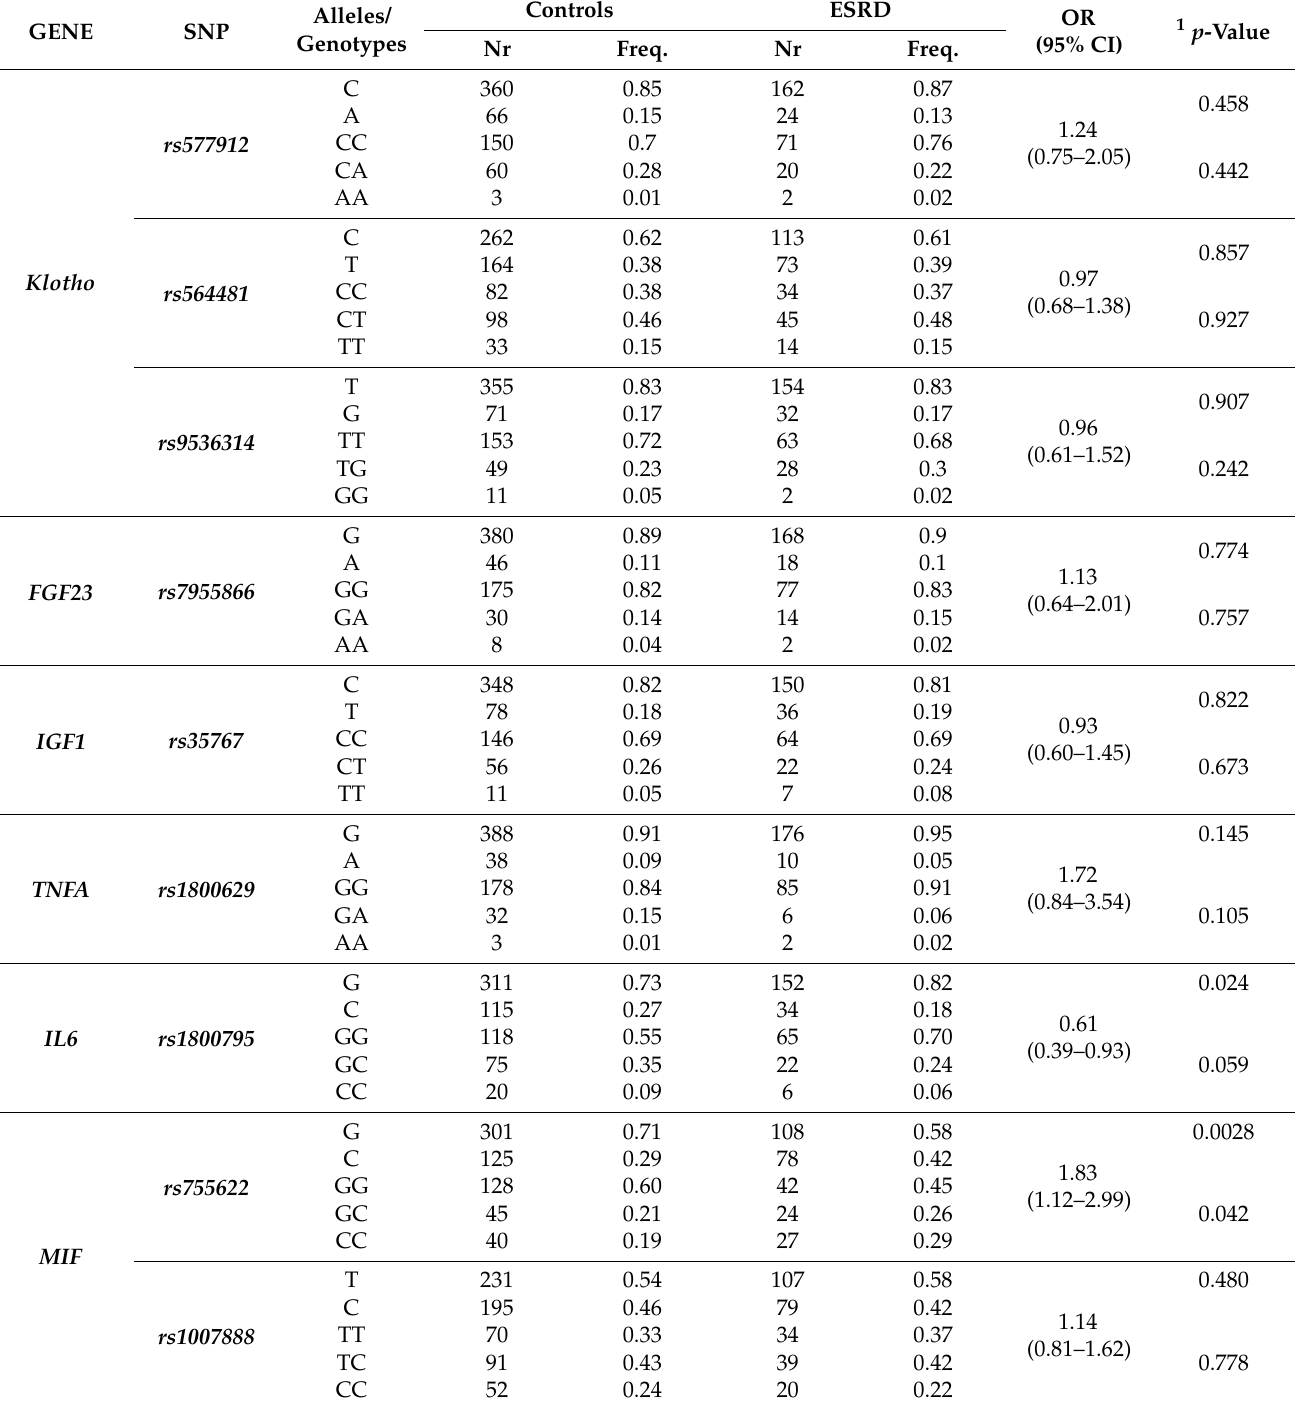
Table 3. SNP allelic and genotypic frequencies of 93 dialyzed patients (ESRD) and 213 control